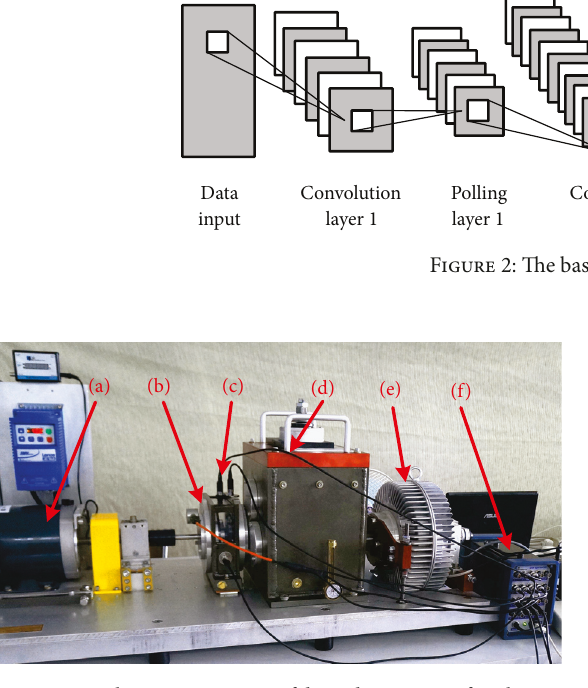
Figure 3: Simulation experiment of degradation states for planetary gear. (a) Controllable motor, (b) planetary gearbox, (c) vibration sensors, (d) spur gearbox, (e) load system, and (f) data acquisition instrument.